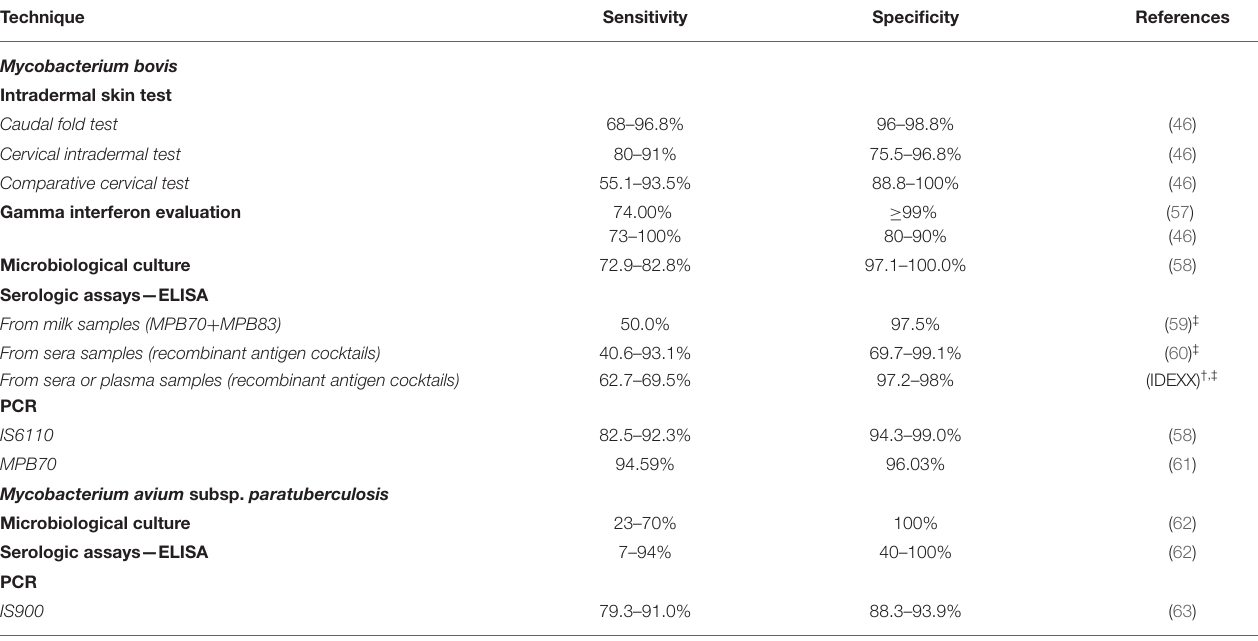
TABLE 2 | Sensitivity and specificity parameters from conventional diagnostic